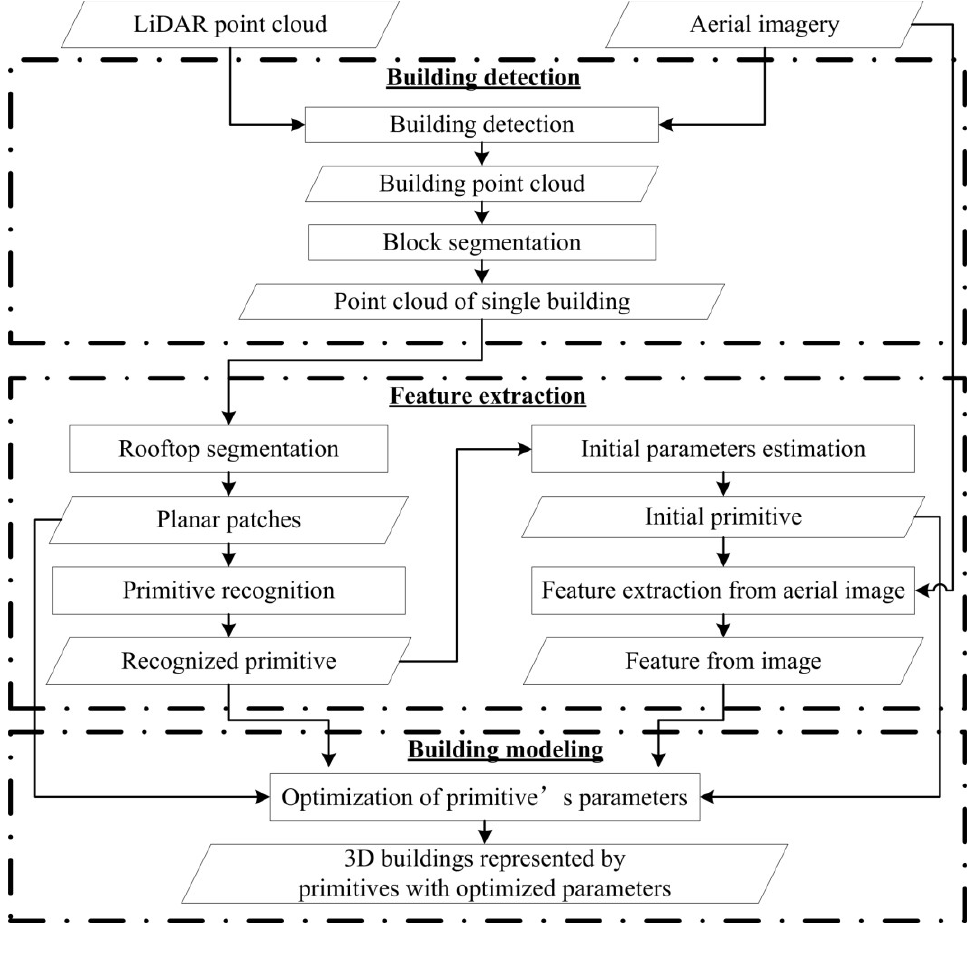
Figure 4. Flowchart of the proposed reconstruction